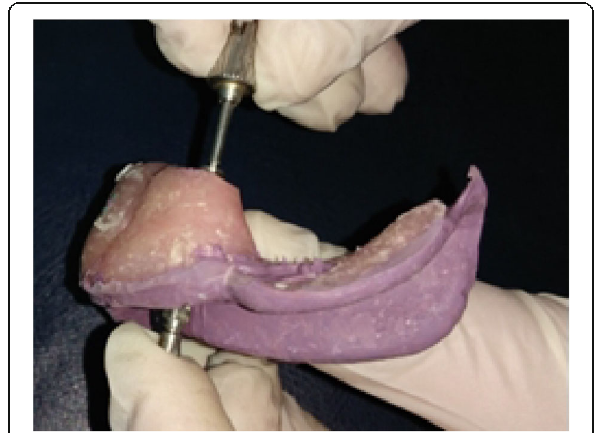
Fig. 2 Connecting the analog with the coping using the guide pin